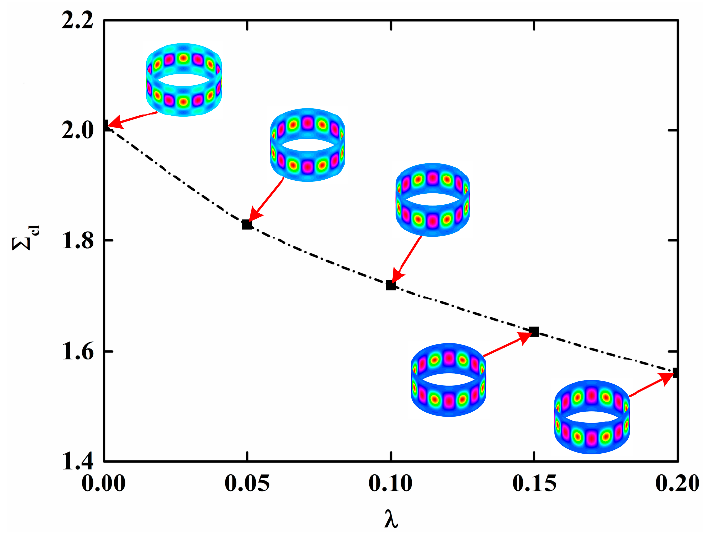
Figure 6. Variation in the critical load of imperfect NFRC cylindrical shells with imperfection amplitude.